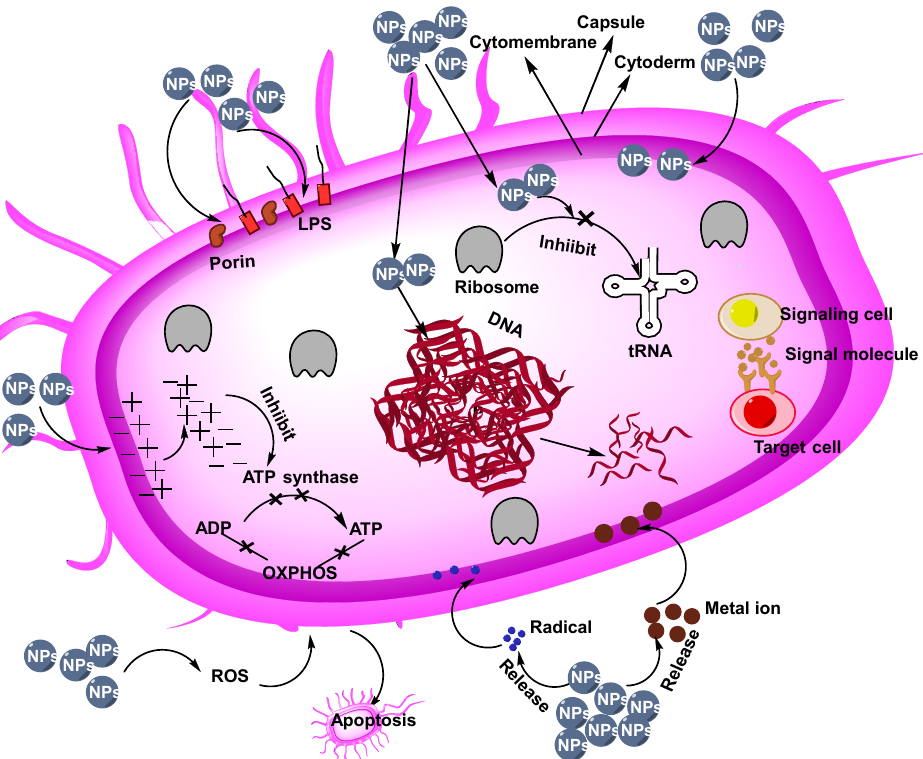
Figure 2. Antibacterial mechanism of nanoparticles (NPs). Many different types of metallic and metal oxide NPs work against bacteria, viruses and other eukaryotic microorganisms, of which AgNPs have been shown to be the most effective [35]. Metallic silver or related silver compounds have been used since ancient times to treat burns and several bacterial infections. With the emergence of antibiotics such as penicillin, the use of silver in the field of antibacterial gradually declined. However, the use of metallic silver and silver compounds as fungicides has again attracted extensive attention due to the widespread problem of drug resistance [21]. AgNPs combined with different types of antibiotics, such as penicillin, erythromycin and vancomycin, can enhance the bactericidal effect on gram-positive bacteria and gram-negative bacteria [36]. Four different formulations of silver–carbon complexes (SCCs), including micelles and NPs, are effective in the range of 0.0005–0.09 kg/m 3 against medically established MDR bacteria such as MDR Acinetobacter baumannii (-), methicillin-resistant Staphylococcus aureus and klebsiella pneumoniae (-) [37]. In addition, the current applications of silver NPS mainly include external medical antibacterial dressings, implantable medical material coatings and so on [38]. Dressings [39], creams and gels made from silver NPs can effectively reduce bacterial infections in chronic wounds [40]. Silver NPs wound dressings containing poly vinyl nano-fibers also have high antibacterial properties [41]. NPs coatings play an important role in implanted medical devices and materials besides being used as antibacterial materials for external use. It is inevitable that exogenous medical